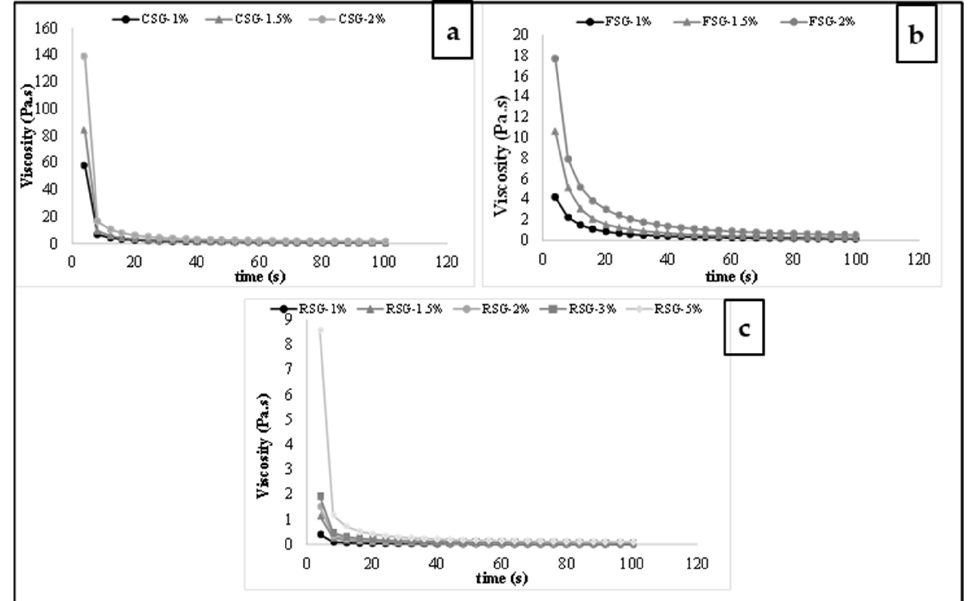
Figure 3. The viscosity of CSG: chia seed byproduct gum, FSG: flaxseed byproduct gum, RSG: rocket seed byproduct gum solutions with different concentrations (( a ) CSG (1–2%), ( b ) FSG (1–2%), ( c ) RSG (1–5%)).